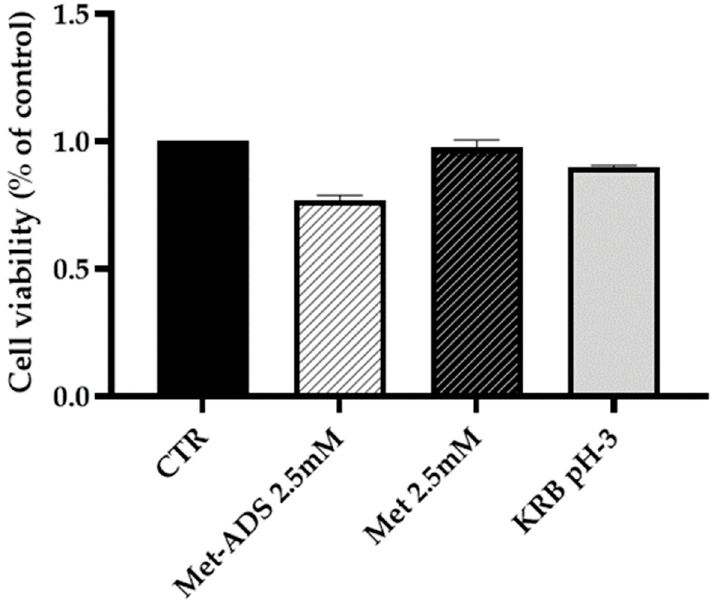
Figure 3. Effect of Met-ADS 2.5 mM and Met 2.5 mM and KRB pH-3 on IPEC-J2 cell viability (percentage of control) after 3 hours inclubation.